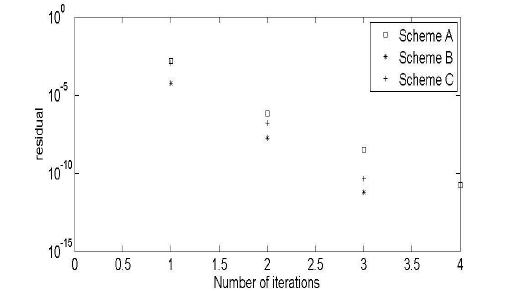
Figure 2. Residual convergence with the three refinement schemes of the academic